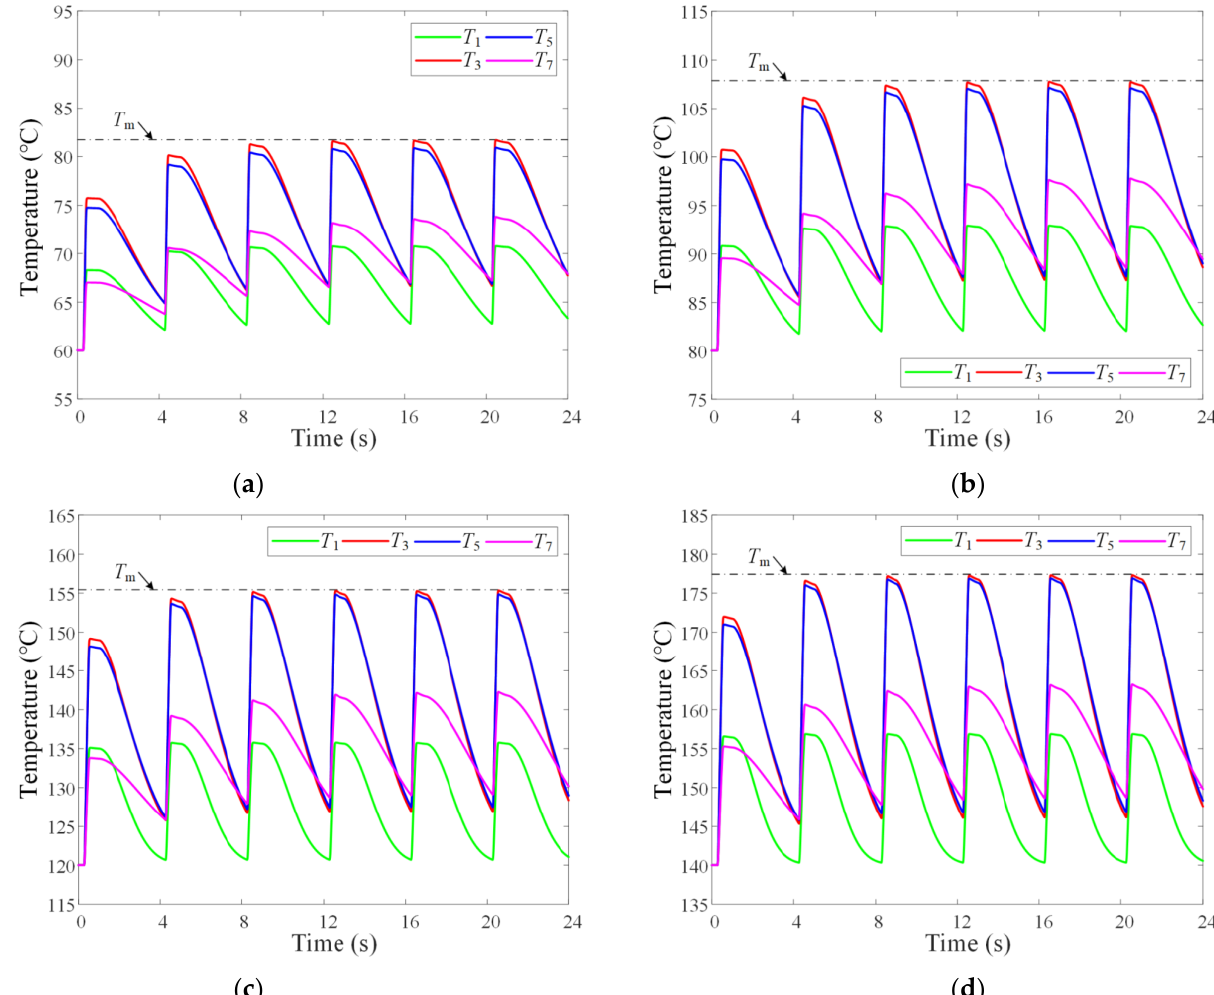
Figure 9. Variation of temperatures with different lubrication oil temperatures: ( a ) 60 °C; ( b ) 80 °C; ( c ) 120 °C; ( d ) 140 °C.